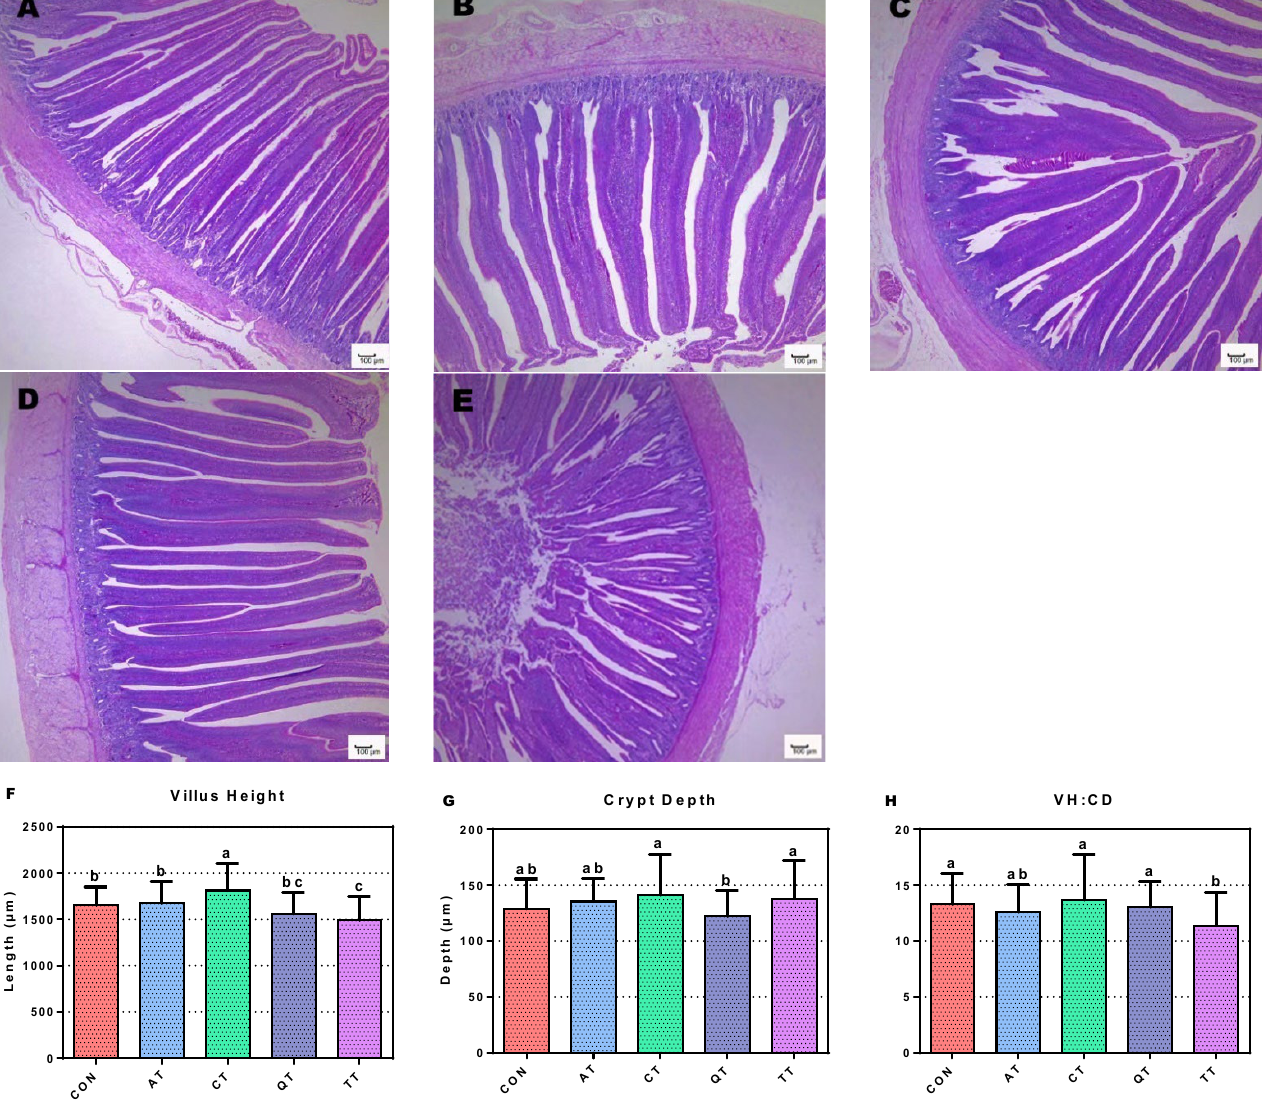
Figure 4. Photomicrograph of the small intestine: jejunum stained with hematoxylin and eosin stain. ( A ) CON; ( B ) AT; ( C ) CT; ( D ) QT; ( E ) TT; ( F ) villus height; ( G ) crypt depth; ( H ) ratio of villus height to crypt depth. Different letters (a, b and c) indicate significant differences ( p < 0.05), while the same letter indicates no significant differences ( p > 0.05). CON, control; AT, Acacia mearnsii tannin; CT, Castanea sativa tannin; QT, Schinopsis lorenzii tannin; TT, Caesalpinia spinosa tannin.